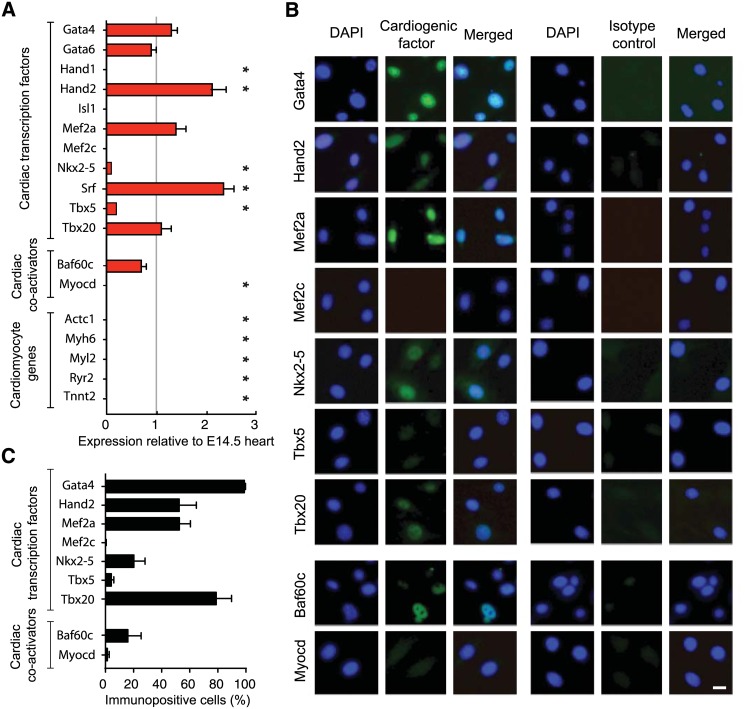
Cardiac transcription factor, co-activator and differentiation marker expression in adult mouse CSCs compared to the embryonic heart.Here and throughout, Lin- / Sca1+ / SP+ CSCs were isolated from adult mouse myocardium and expanded for five passages before use. A: QRT-PCR. mRNA levels in CSCs (red) are expressed relative to the E14.5 mouse embryonic heart and are the mean ± SD of three independent experiments. *, p < 0.05 for CSCs versus embryonic heart. B, C: Immunocytocvhemistry. B: CSCs were cultured to subconfluent density and fixed for immunostaining. The transcription factors Gata4, Hand2, Mef2a, Nkx2-5, Tbx5, Tbx20 and chromatin remodeling protein Baf60c were present as nuclear-localized proteins, whereas neither Mef2c nor Myocd was detected. Factor-specific primary antibody binding was visualized using species-specific secondary antibodies conjugated with Alexa 488. Isotype control primary anitibodies were used as the control. Nuclei were counter-stained with DAPI. Bar, 20 μm. C: Quantitation of immunostaining by automated high-content image analysis. Data are the mean ± SD of three wells (≥ 2500 cells counted per well for each protein) and were concordant with the QRT-PCR profile for all nine factors tested by both methods.